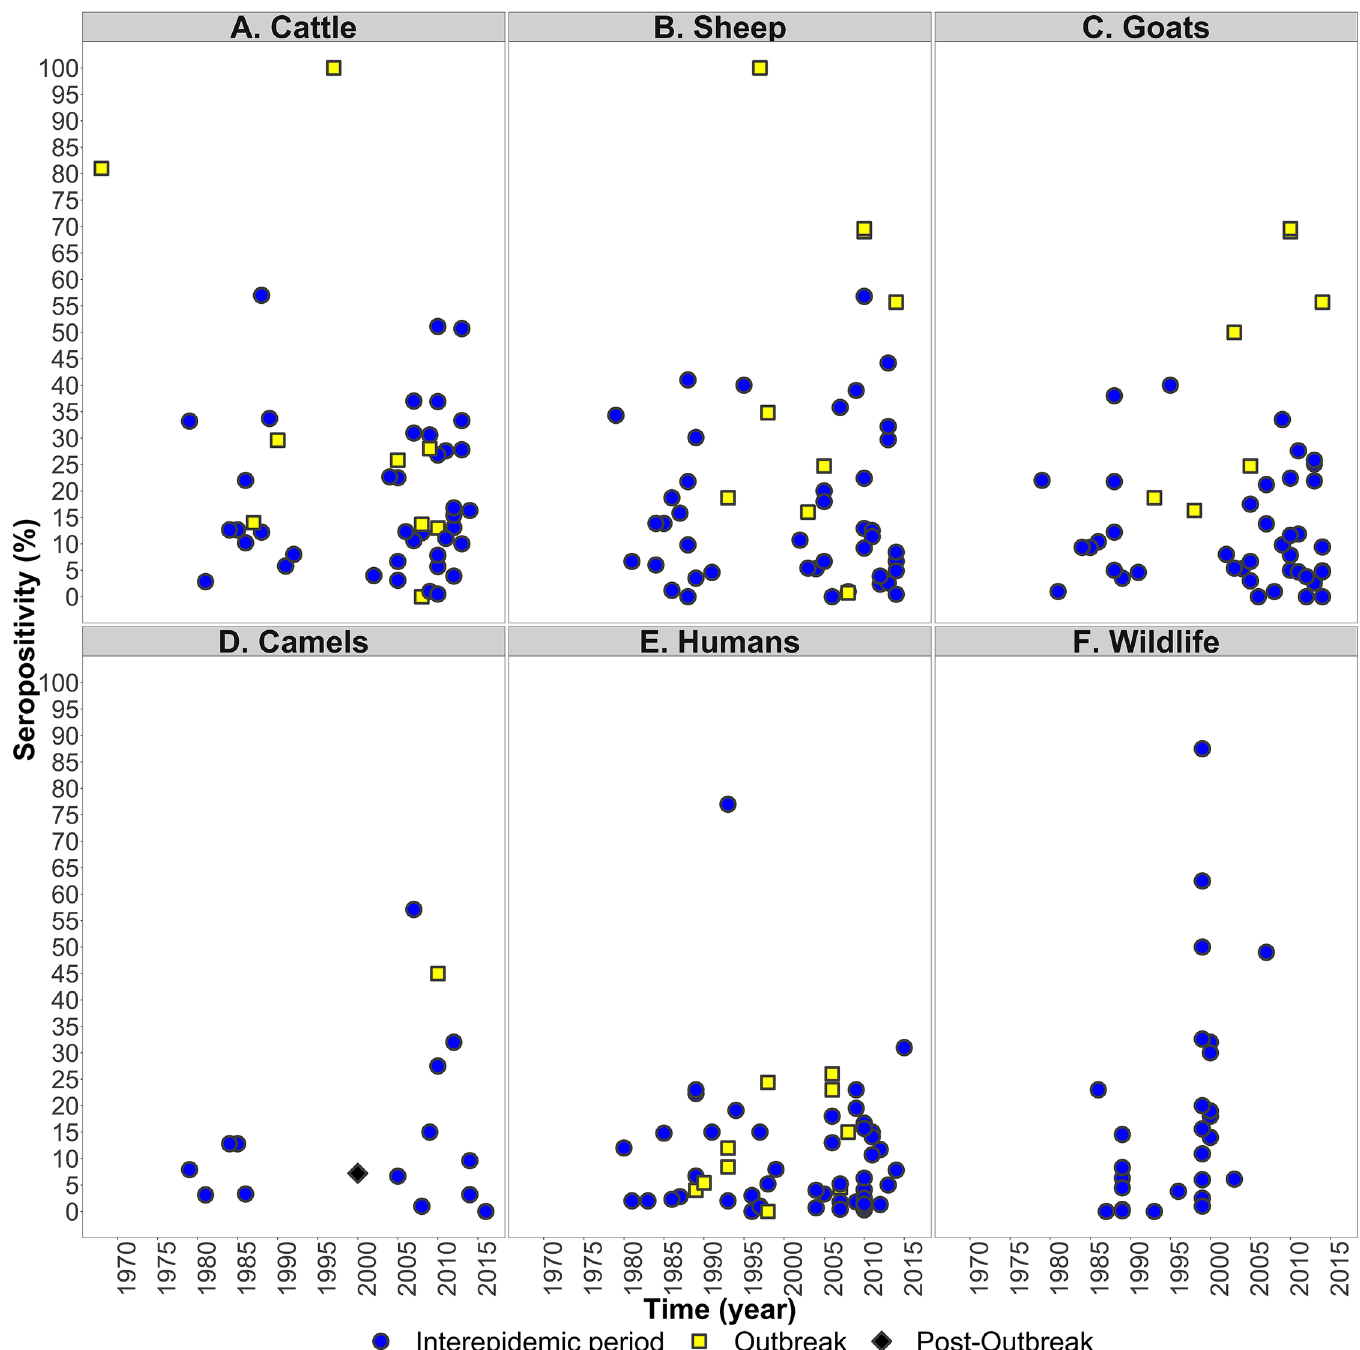
Fig 5. Reported seroprevalence (% individuals seropositive) of Rift Valley fever virus in (A) cattle, (B) sheep, (C) goats, (D) camels, (E) humans and (F) wildlife in African countries, during 1968–2016 (year study was conducted). Symbols indicate whether studies were reported as being carried out during outbreaks (filled yellow squares), immediately after outbreaks (filled back diamonds) or during inter-epidemic periods (filled blue